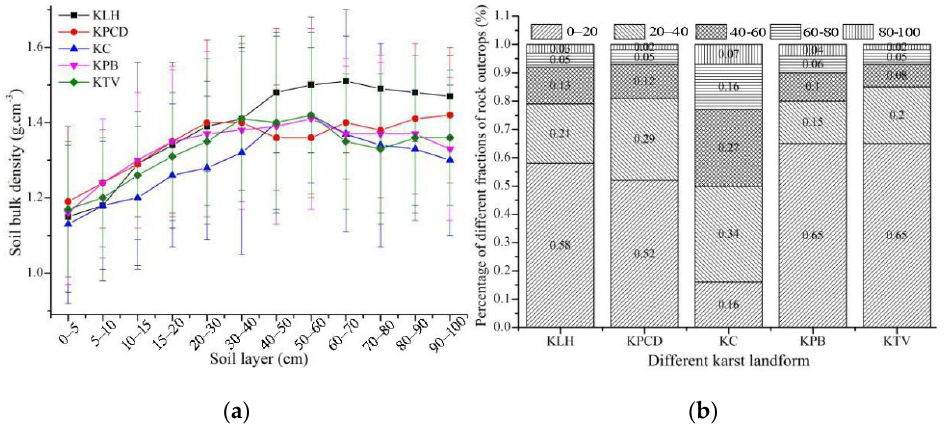
Figure 1. Information on SBD and rock outcrops in different soil layers. Panel ( a ) shows the SBD in different soil layers; panel ( b ) shows the percentages of rock outcrop exposure in different karst landforms. Table 2. The spatial distributions of SOC and SOCD in soil profiles on different karst